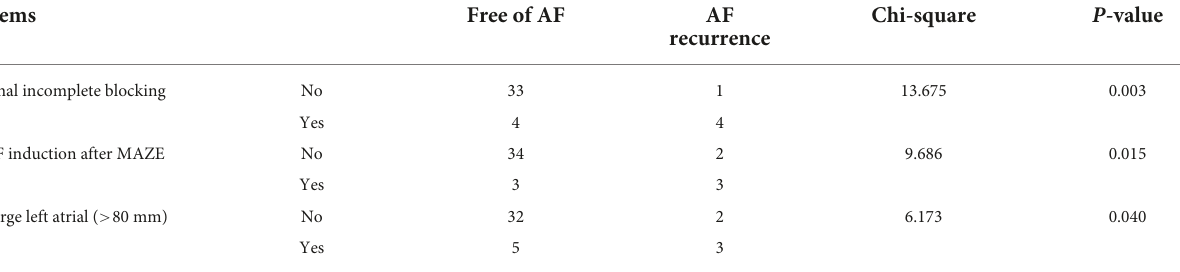
TABLE 5 Correlation between AF recurrence with final incomplete blocking, AF inducibility, and large left atrial in the Electrophysio-Maze group.